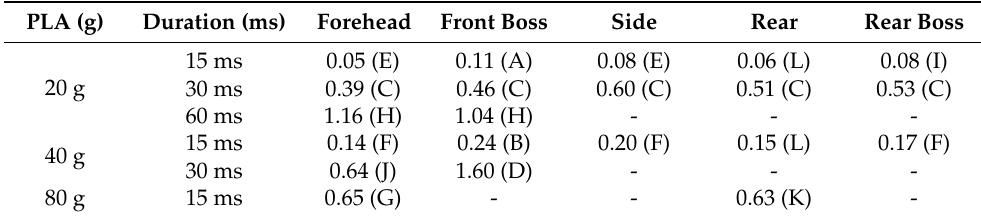
Table 1. Drop heights (m) and foam combination (A–L) (Appendices A and B) for each impact scenario tested. Those unable to be tested are left